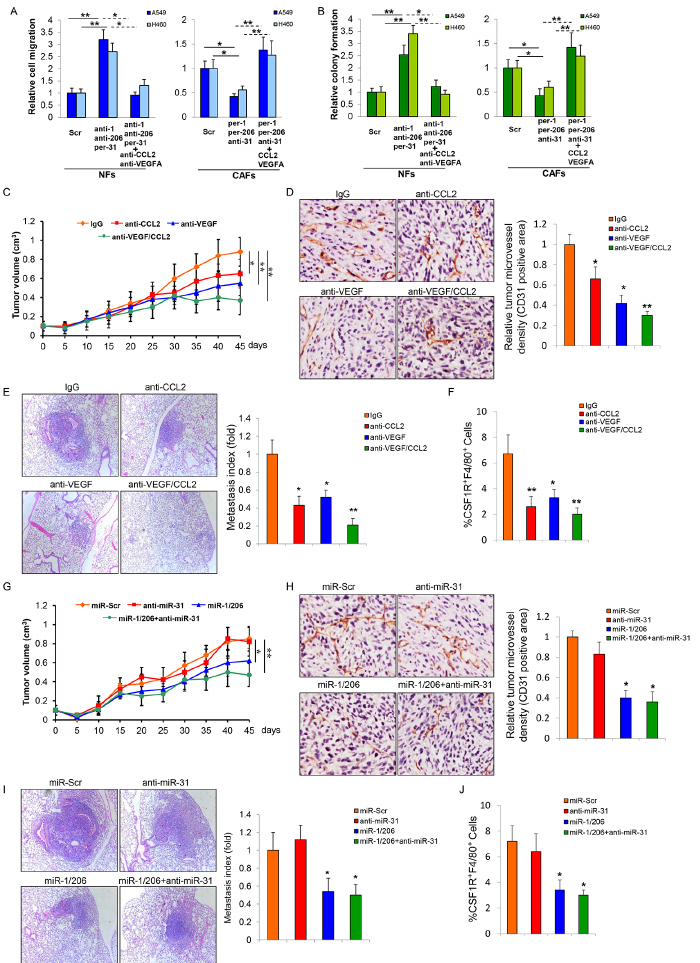
Fig 5. Targeting CCL2/VEGFA via antibodies or miRNAs administration inhibits lung tumor growth. (A) NFs-Scr, NFs-TM, CAFs-TM, or CAFs-Scr was co-cultured with LCCs for 48h and CM was collected. CM from LCCs-NFs-TM co-culture was treated with or without anti-CCL2/VEGFA; CM from LCCs-CAFs-TM co- culture was treated with or without CCL2/VEGFA. Cell migration assay was performed to assess LCCs migration efficiency in response to those CM. (B) Colony formation assay was performed to determine LCCs colony formation ability when co-cultured with NFs-Scr, NFs-TM, CAFs-TM, or CAFs-Scr with or without addition of anti-CCL2/VEGFA or CCL2/VEGFA as indicated in the Figure B. (C-F) A549 cells were subcutaneously co-injected with CAFs into immunodeficient mice. For neutralizing antibodies treatment, after 7 days of tumor implantation, the mice were treated with mouse IgG or anti-mouse CCL2 and/or anti-VEGF 164 at 2 mg/kg/dose by intraperitoneal injection (i.p.) injections twice weekly for up to 6 weeks (C). Representative CD31-stained section of tumors. The relative tumor microvessel density were presented as Mean ± SEM; (n = 8) (D). Representative HE-stained section of lungs of mice bearing the indicated tumors. The lung metastasis indices pooled within each cohort of mice in (C) are expressed (mean ± SEM; n = 8) (E). The percentage of CSF-1R+F4/80+ in tumors was determined by flow cytometry assay (F) (mean ± SEM; n = 8). * p < 0.05, ** p < 0.001 vs IgG. (G-J) For miRNAs injection treatment, miRNAs were formulated with MaxSuppressor in vivo RNALancerII and formulated miRNAs were administered intravenously (i.v.) by tail vein injections every 5 days starting on day 5 after tumor cells implantation (G). Representative CD31-stained section of tumors. The relative tumor microvessel density were presented as Mean ± SEM; (n = 8) (H). Representative HE-stained section of lungs of mice bearing the indicated tumors. The lung metastasis indices pooled within each cohort of mice in (G) are expressed (mean ± SEM; n = 8) (I). The percentage of CSF-1R+F4/80+ in tumors was determined by flow cytometry assay (J) (mean ± SEM; n = 8). * p < 0.05, ** p < 0.001 vs